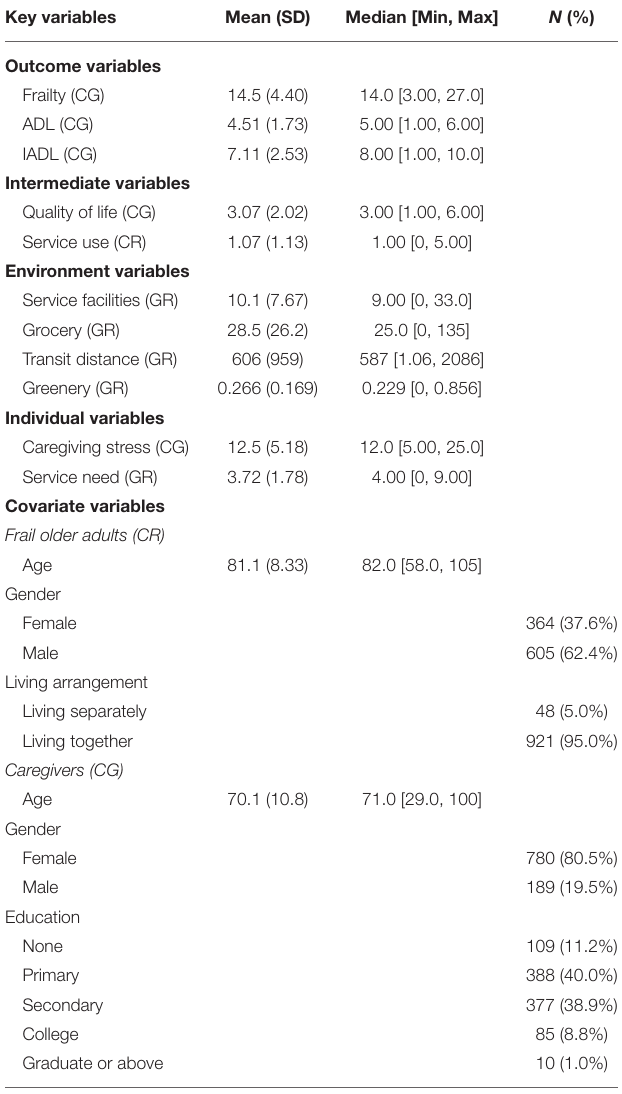
TABLE 1 | Health outcome and preventive